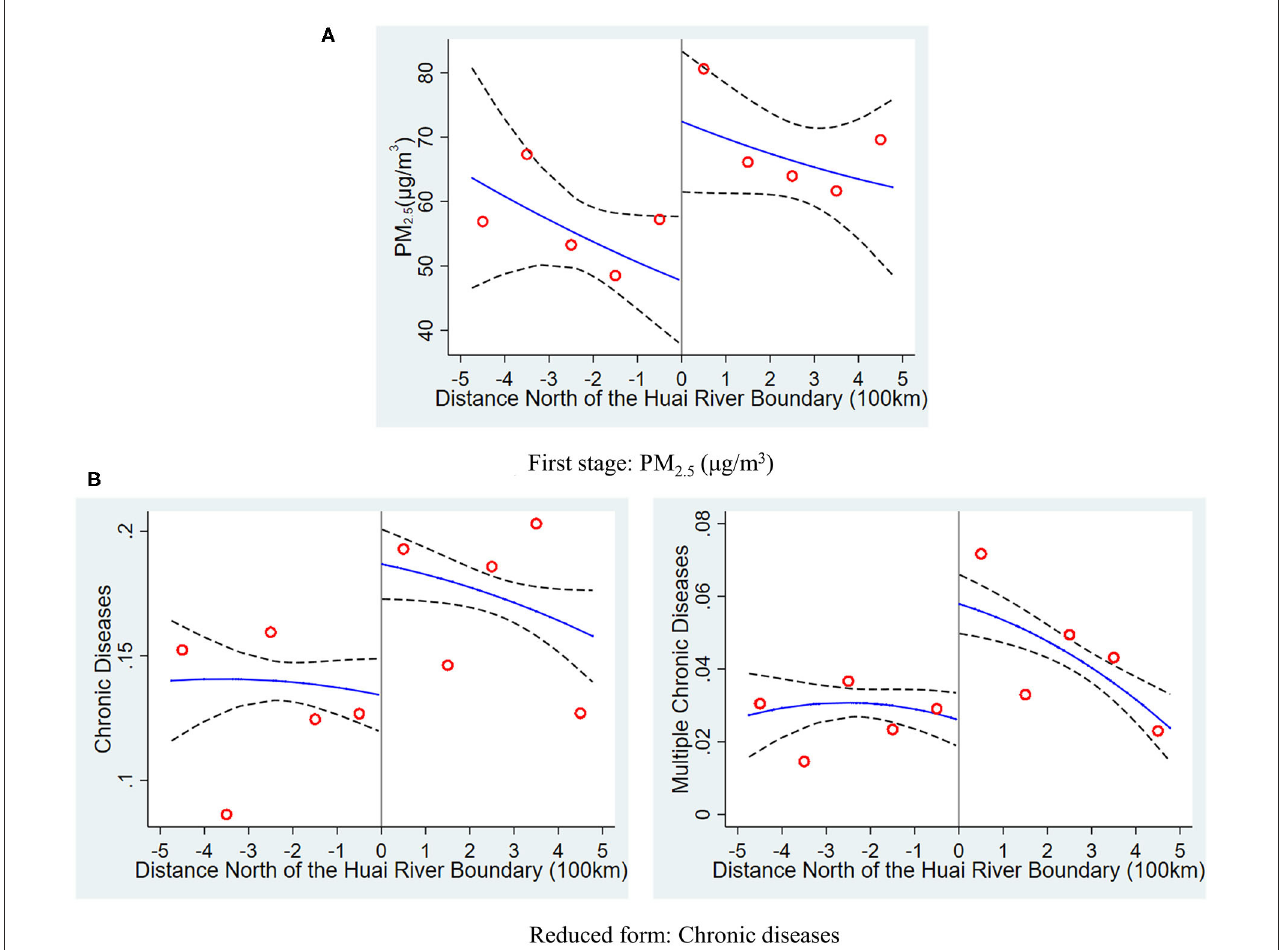
FIGURE1 Distribution of pollution exposure and chronic diseases at the Huai river boundary. The graphs show the average value of PM 2.5 exposure and rates of chronic diseases north and south of the Huai River. The horizontal axis is the distance north (positive values) and south (negative values) from the sample location to the Huai River. The scatterplot in (A) is the means of PM 2.5 within 100km bins, and the solid and dashed lines are the regression fit and associated confidence intervals, respectively, based on the quadratic polynomial regression of PM 2.5 exposure on distance from the Huai River estimated separately on each side of the river. The right and left columns of (B) present the results for at least one chronic disease and multiple chronic diseases, respectively, estimated in the same manner as shown in (A)